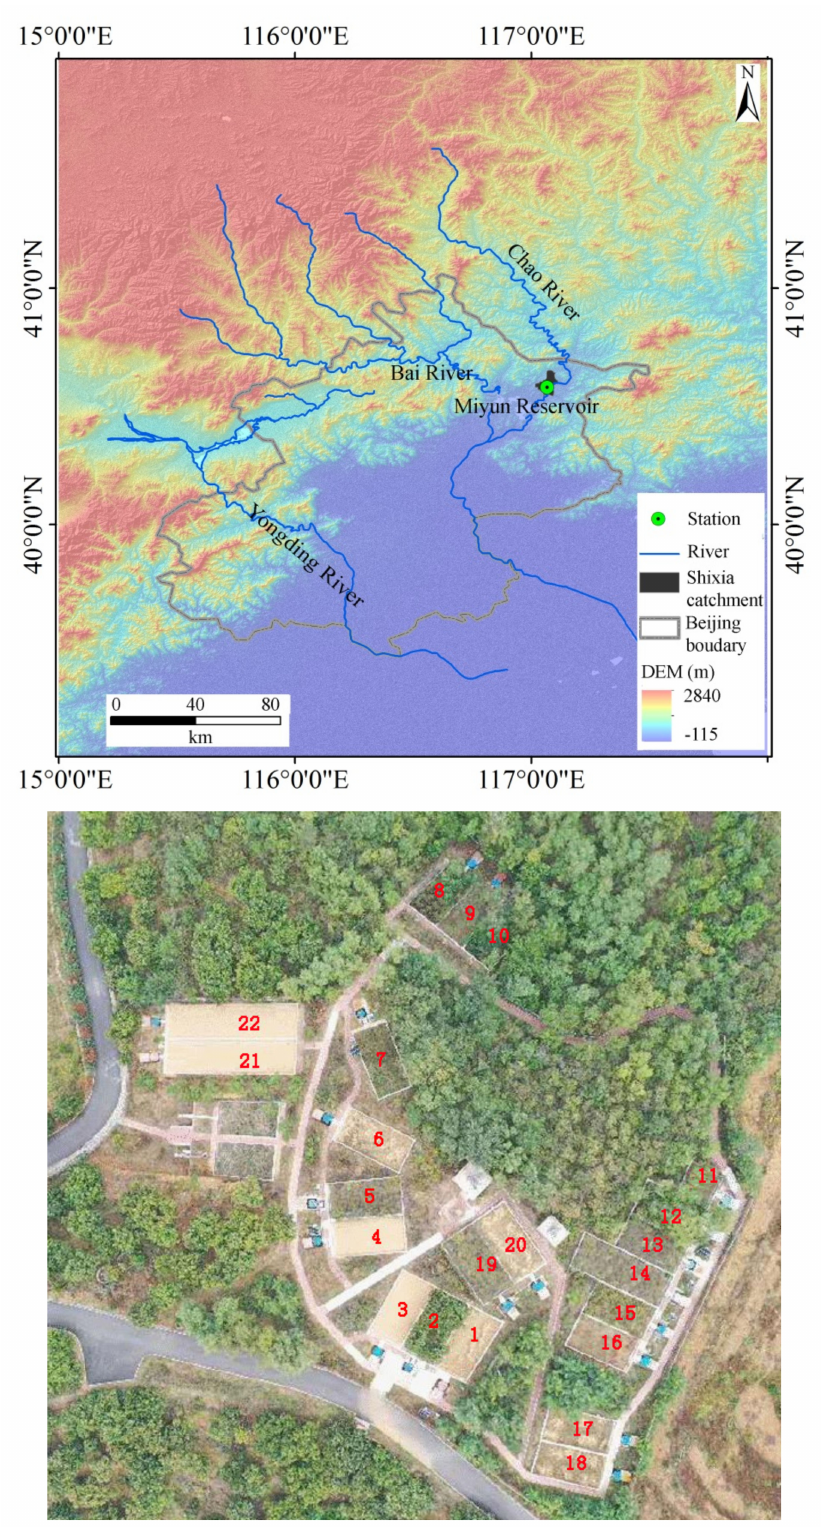
Figure 1. Site of the experimental station and the runoff plots. The numbers in red color in the lower figure represent runoff